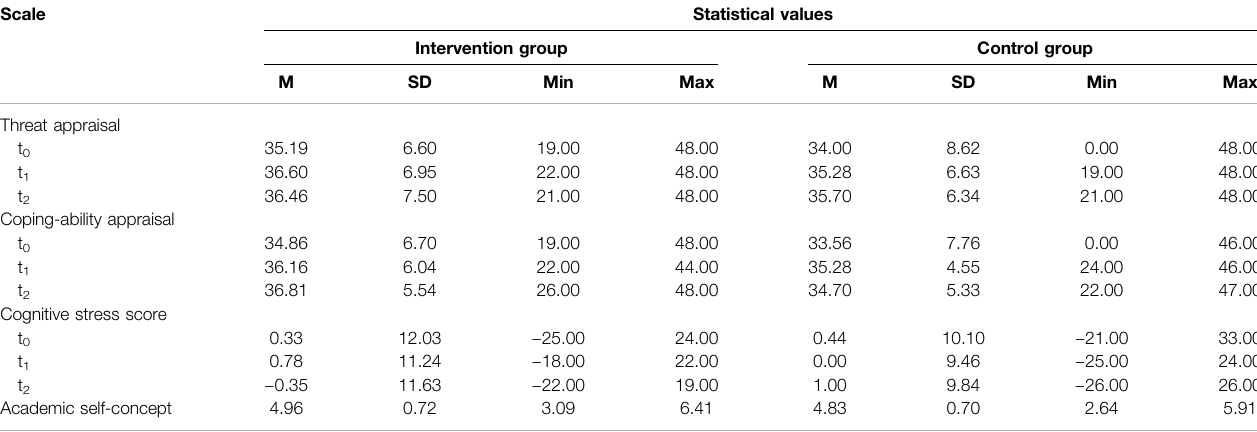
TABLE 1 | Means, SD, and range for threat appraisal, coping-ability appraisal, and cognitive stress appraisal scores for all three measurement points and academic self- concept at premeasurement separated by condition. Scale Statistical